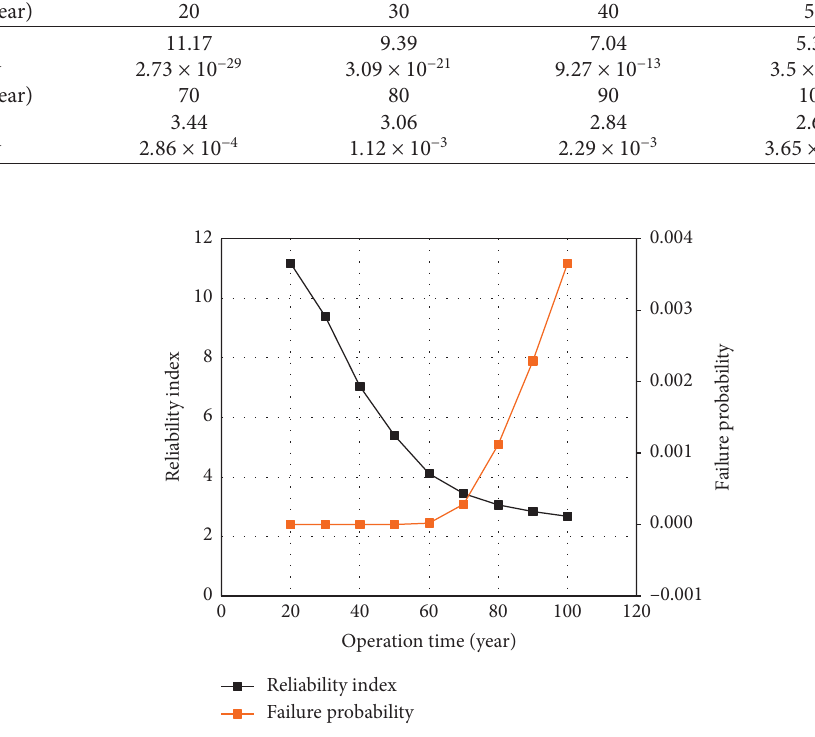
Figure 14: Reliability index and failure